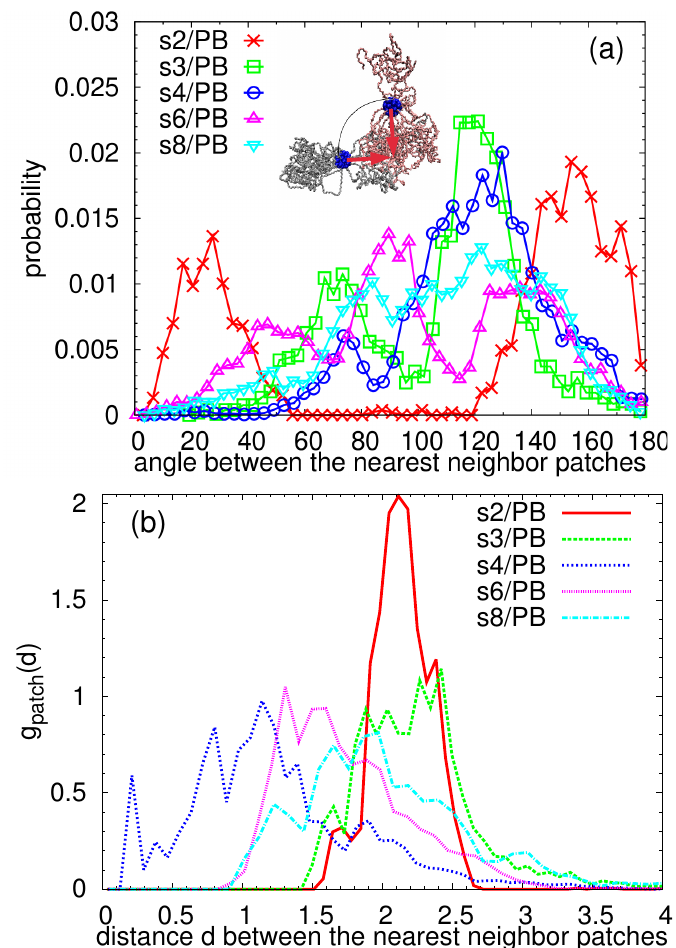
Figure 8. ( a ) The probability distribution function of the intermolecular angles (scheme in the inset) between the nearest neighbor patches; ( b ) radial distribution function of the intermolecular distances between the centers of mass of the nearest neighbor